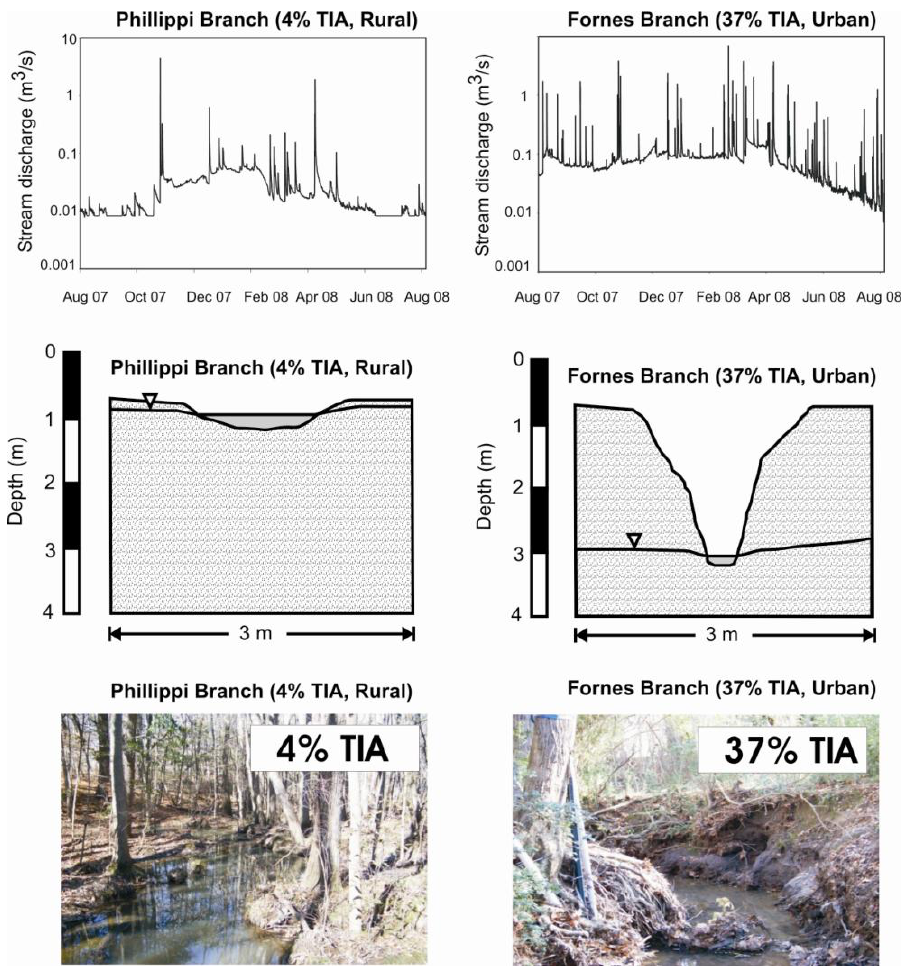
Figure 6. A comparison of the annual hydrographs of rural (Phillippi Branch, 4% TIA) and urban (Fornes Branch, 37% TIA) streams in the Coastal Plain of NC (Greenville, NC) and the stream channel cross-sections, indicating the channel incision and enlargement response to urbanization documented in the region [38,71]. Photo of Phillippi Branch is courtesy of Dr. Mark